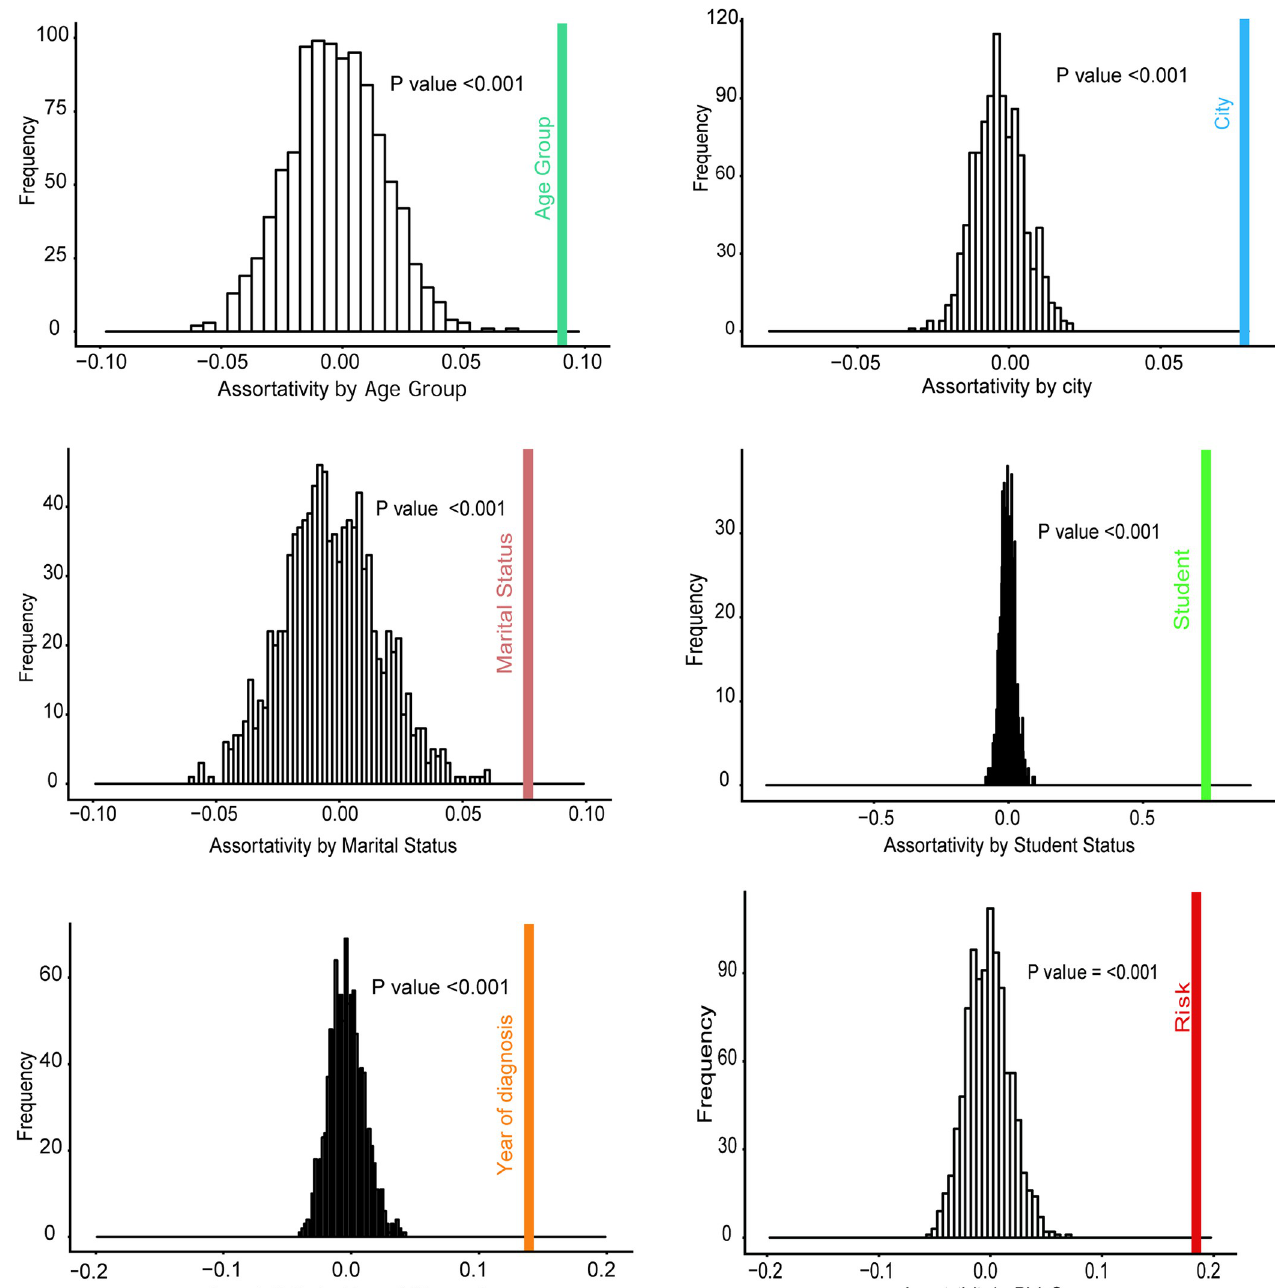
Fig 4. Assortativity analysis among linked individuals. The random value is 1000 times, and “1” indicates linked individuals originating from the same category, whereas “-1” indicated those from different category. Assortativity analysis by age group, student status, city of residence, marital status, and year of diagnosis, respectively. Assortativity index for above were AI age = 0.090, AI city = 0.078, AI marital = 0.076, AI student = 0.740, AI year = 0.140, and AI risk =